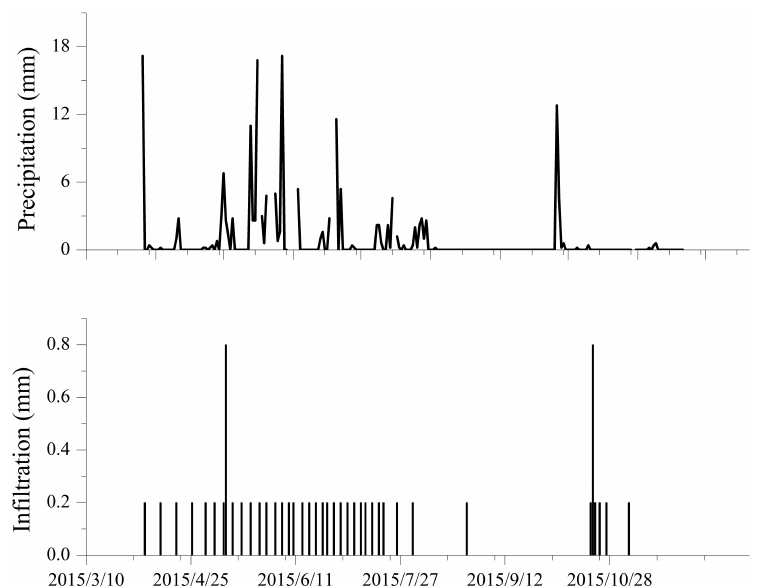
Figure 5. Precipitation and DSR patterns in